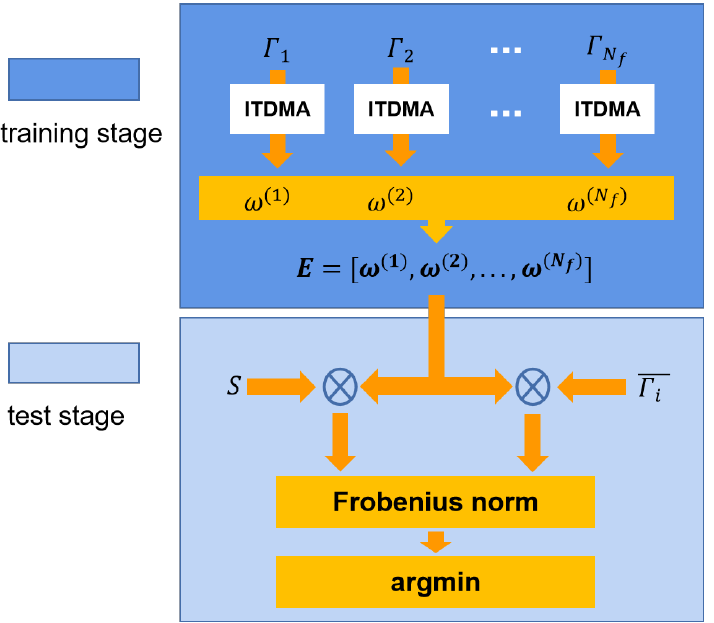
Figure 3. Basic workflow of ITDMA for SSVEP